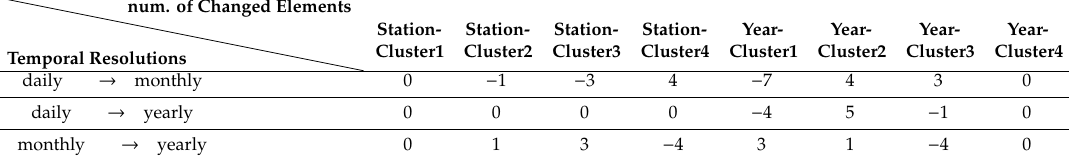
Figure 8. Comparisons of station-clusters ( a ) and year-clusters ( b ) in Dutch temperature data at daily, monthly and yearly resolutions. Table 1. The number of elements changed in station-clusters and year-clusters at different temporal resolutions.